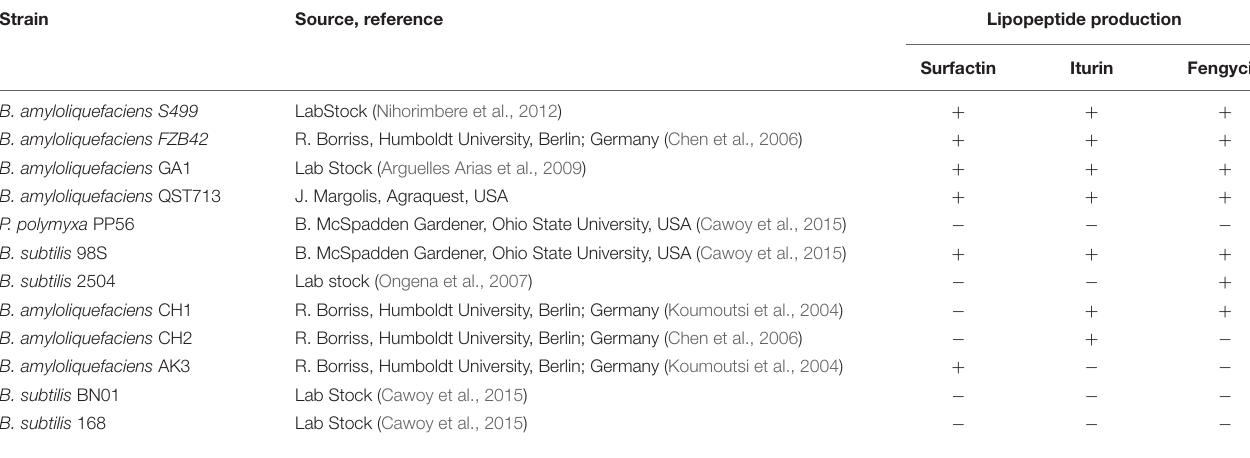
TABLE 1 | Bacterial strains used in this study and their abilities to produce the three different CLP families. Strain Source,